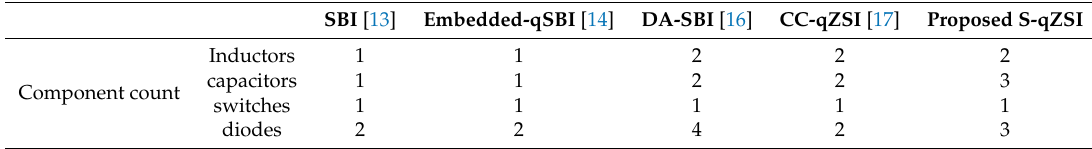
Table 2. Comparison of the number of the components in the proposed Sq-ZSI.